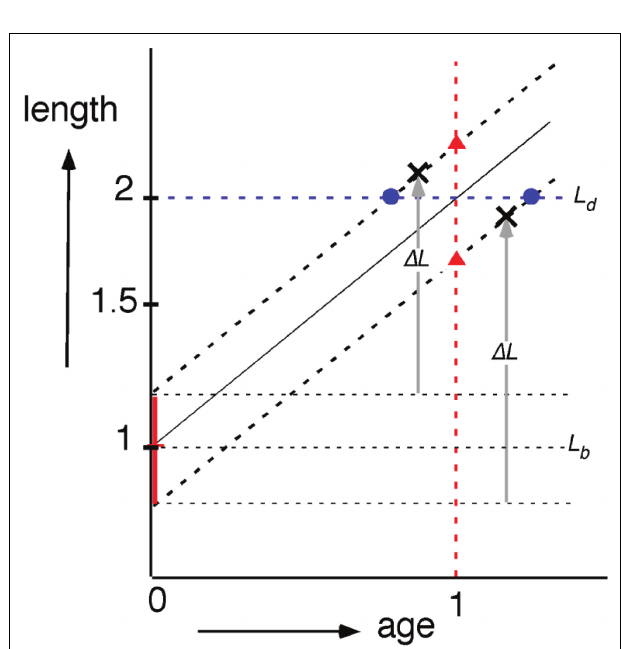
FIGURE 4 | Escherichia coli B/r cells prepared for electron microscopy by agar filtration, 60 min after a nutritional shift-up from (cid:28) 1 = 72 to (cid:28) 2 = 24 min (cf. Figure 3 in Nanninga and Woldringh, 1985). The nucleoids